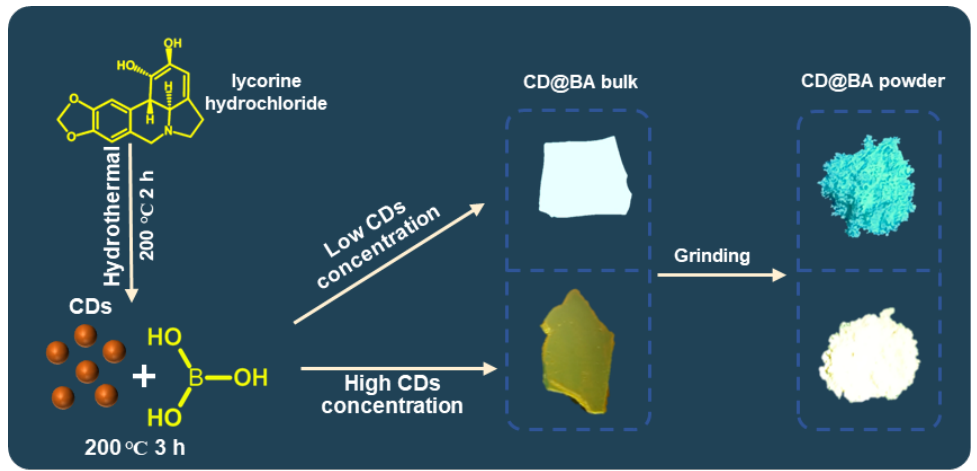
Figure 1. Schematic illustration of the preparation procedure for the CDs and CD@BA bulk powder.